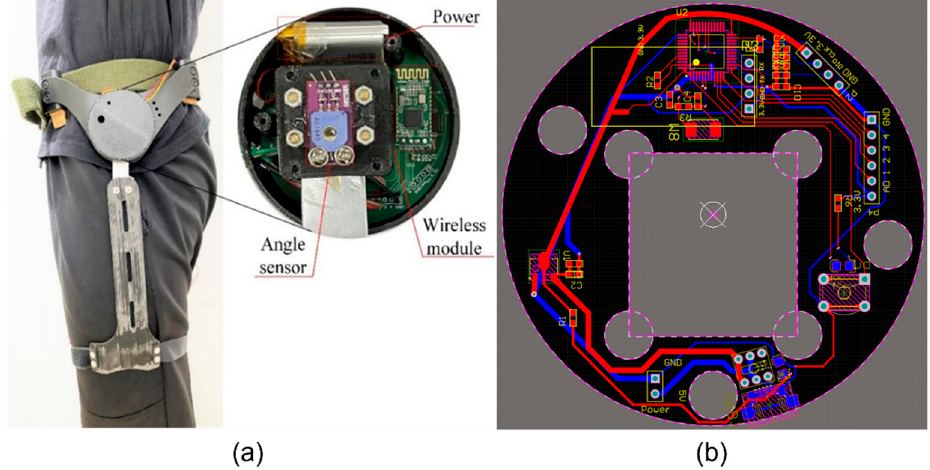
Figure 2. ( a ) Wearable hip gait collection device. ( b ) Circuit design of the collection system.